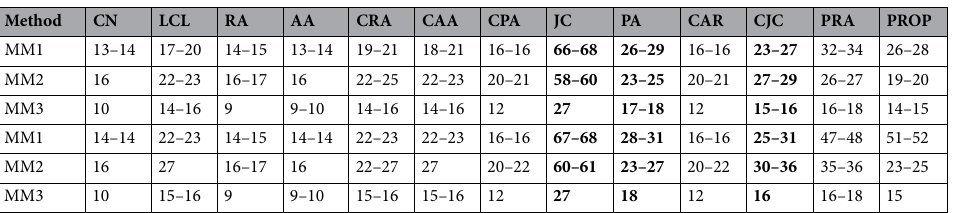
Table 4. Rows 1–3 (not counting the header row) of the top partition refers to counts of unique diseases. The bottom three rows give the order of the lowest disease predicted by each method, when diseases are sorted in descending order by their node degree. The bold shows that the similarity indices suffer from low prediction